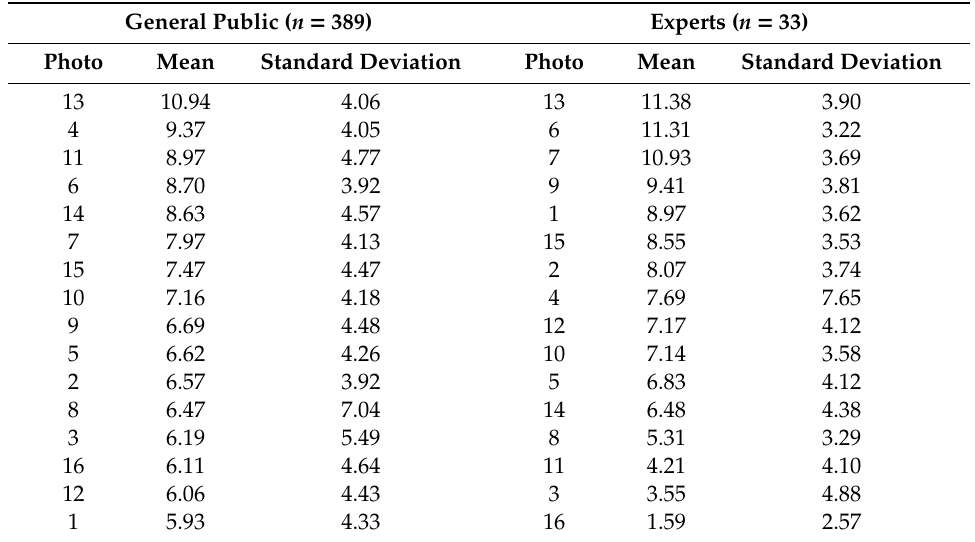
Table 1. Ranking of landscape preferences for general public and experts (see photographs in Figure